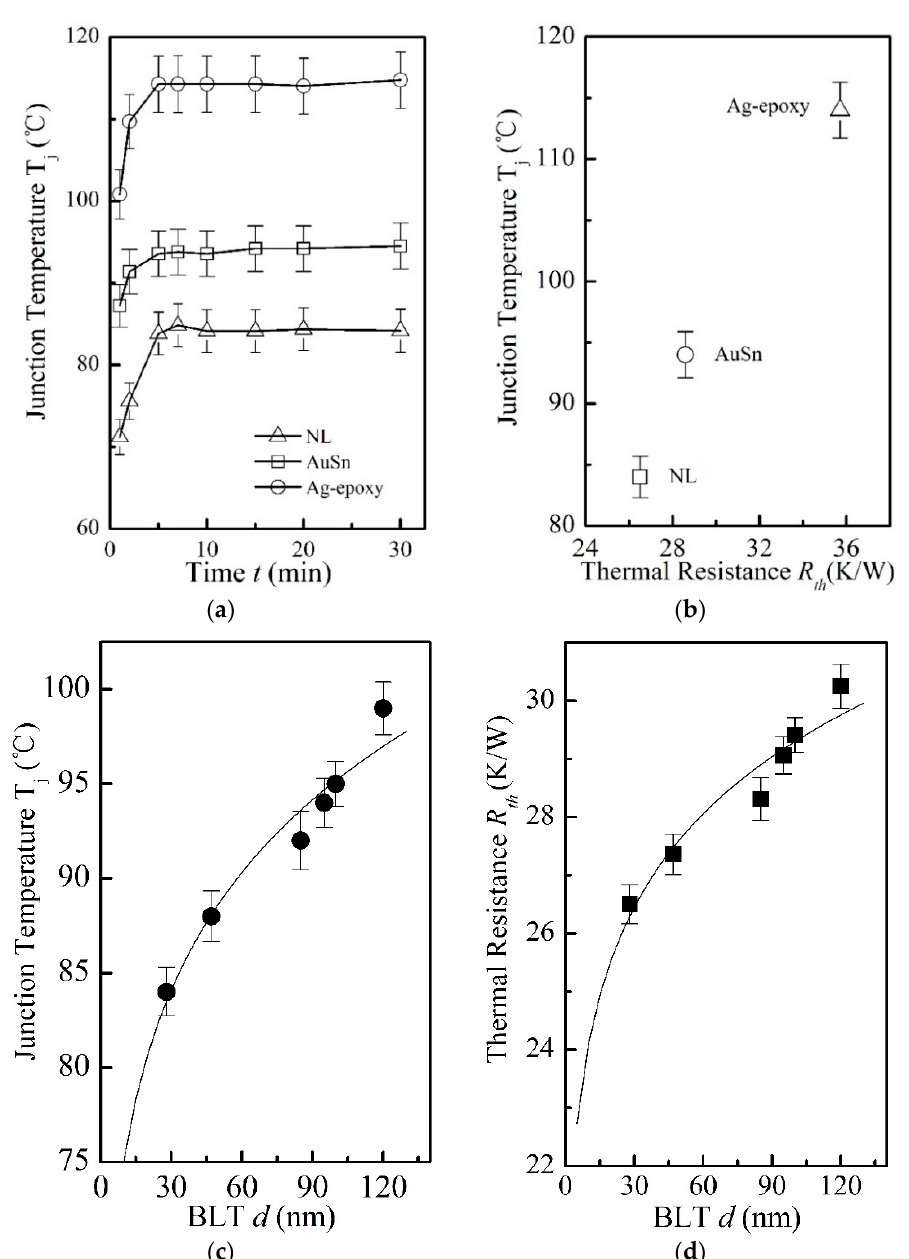
Figure 5. ( a ) The die junction temperature ( T j ) of the devices made by three different die–substrate bonding methods: the open triangle symbol ( ∆ ) represents the experimental measurement of T j for the device made with the NL approach with a BLT of 28 ± 5 nm. The open square symbol ( □ ) represents T j data for the device made by the AuSn bonding with an industrial standard BLT value of 20 ± 2 μ m, the open circle symbol ( ○ ) represents T j data for the device made w with Ag-epoxy bonding with an industrial standard BLT value of 25 ± 2 µ m. The solid lines represent the best fitting. ( b ) The relationship between T j and R th : the open square symbol ( (cid:3) ) represents NL bonding with BLT = 28 ± 5 nm, the open circle symbol ( ○ ) represents AuSn bonding, the open triangle symbol ( Δ ) represents Ag-epoxy bonding. ( c ) For the devices made by the NL bonding, T j is found to decrease with the decreasing BLT, which can be described by T j = 59.311 ( BLT ) 0.1027 (the solid curve), and the solid circle symbol ( • ) represents the experimental data for T j ; ( d ) For the device made by the NL bonding, R th is found to decrease with the decreasing BLT, as described by R th = 19.826 ( BLT ) 0.0848 (the solid curve). The solid square symbol ( (cid:4) ) represents the extracted thermal resistance R th